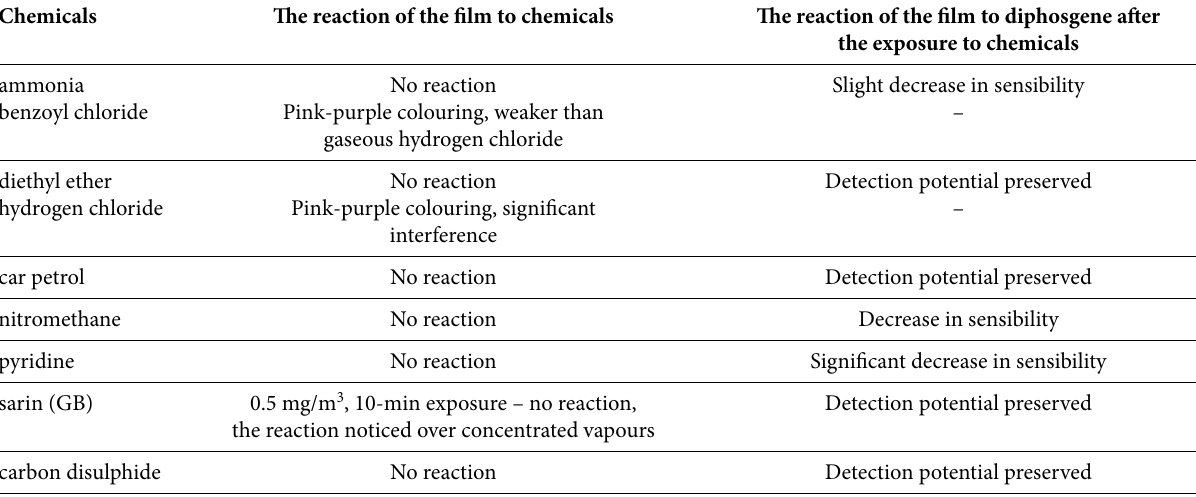
Table 1: The overview of the interferences of the proposed detection film, the substances were tested in the form of concentrated gases.